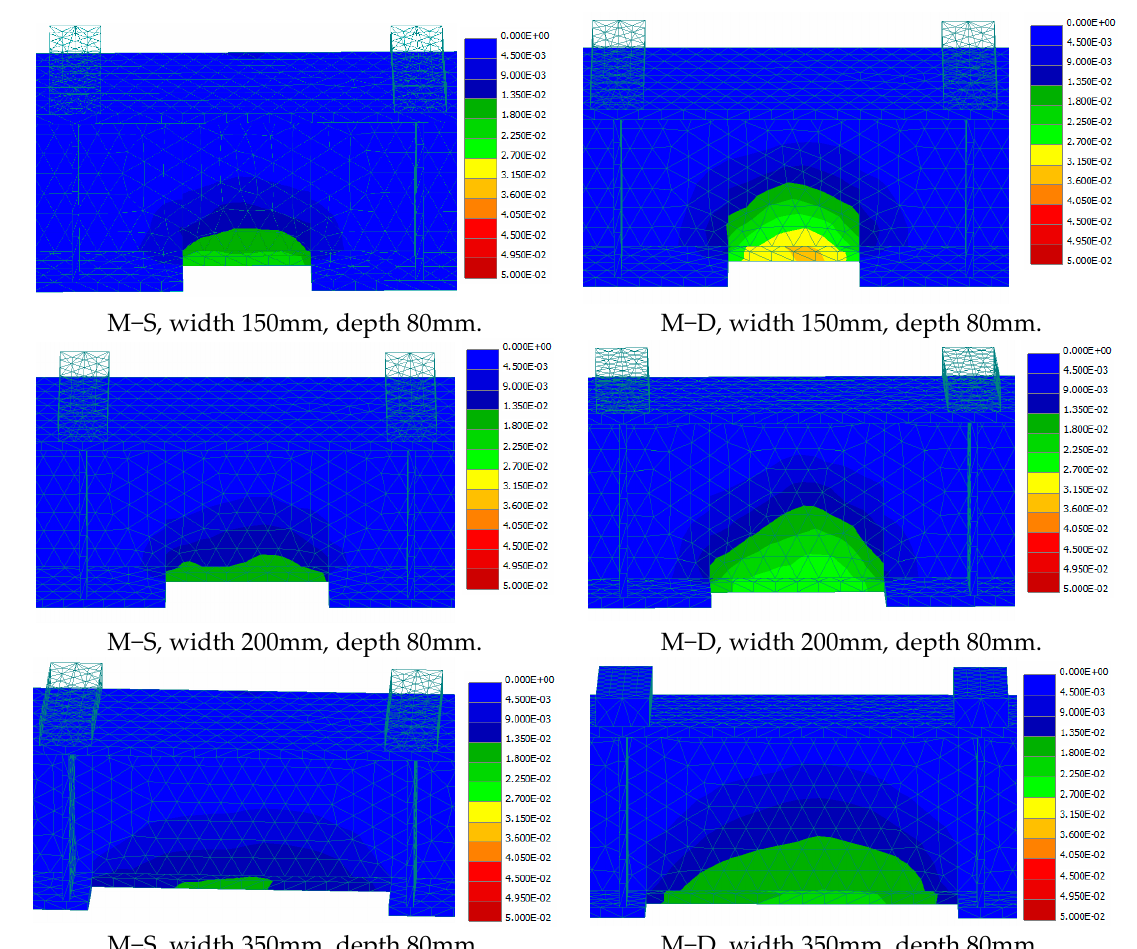
Figure 13. Strain distribution with the middle third segment of the beams. beam was represented in Figure 14, and numerical relative stiffness of the damaged steel beams with respect to the control beam numerical stiffness versus numerical midspan deflections were drawn in Figure 15.